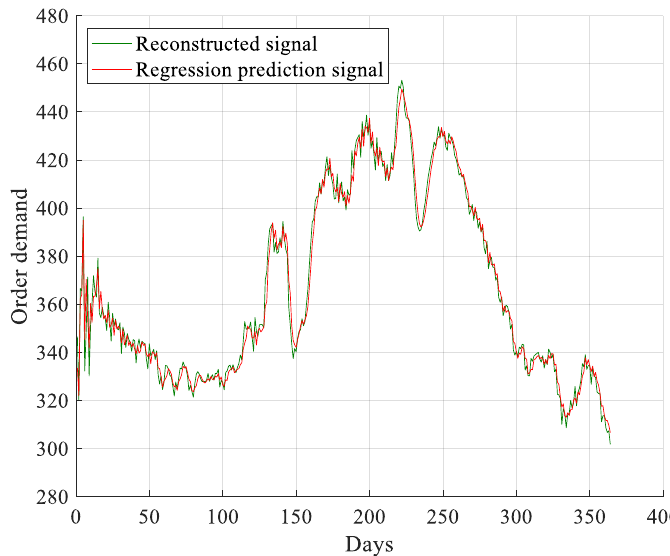
Figure 10. Reconstructed signal regression prediction diagram .